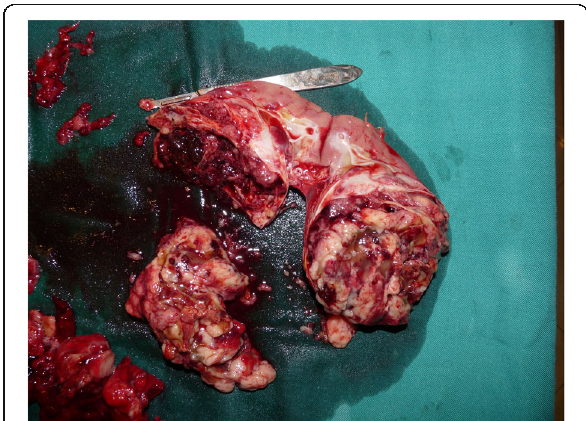
Fig. 5 Tumor rupture and spillage during upfront